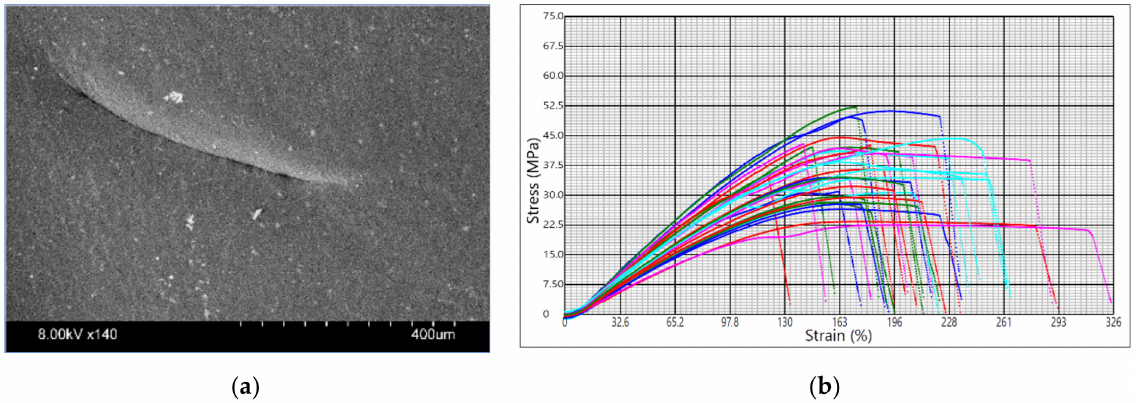
Figure 3. Prusament PLA Galaxy Silver: ( a ) sample surface SEM image; ( b ) tensile test graph.